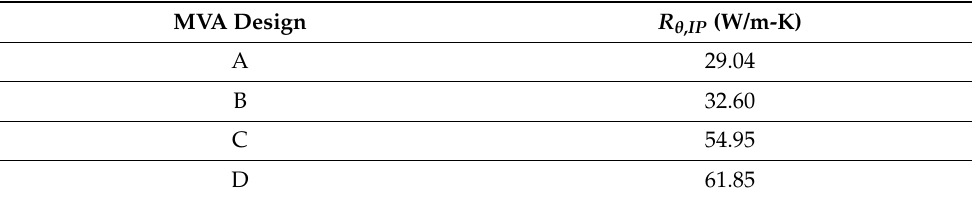
Table 4. In-plane thermal conductivity for each MVA design.